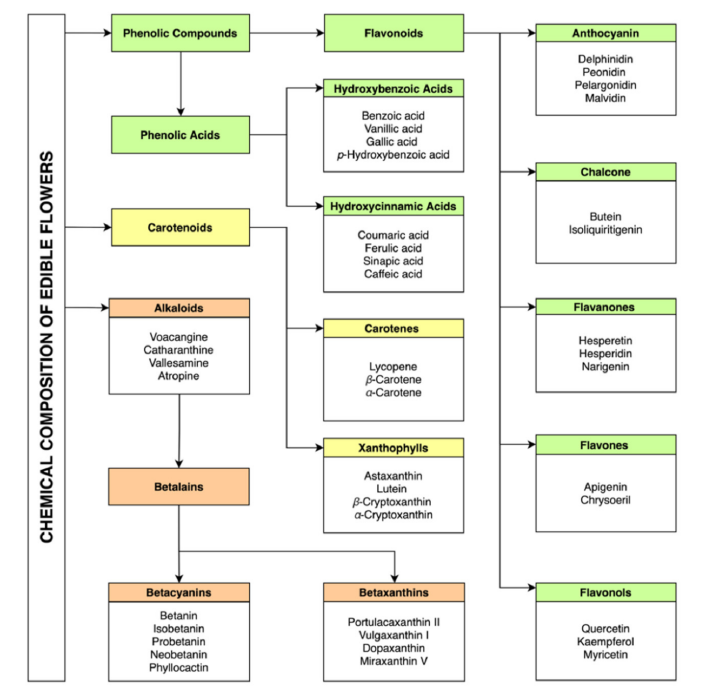
Figure 1. Examples of chemical compounds commonly found in edible flowers (authorship by the